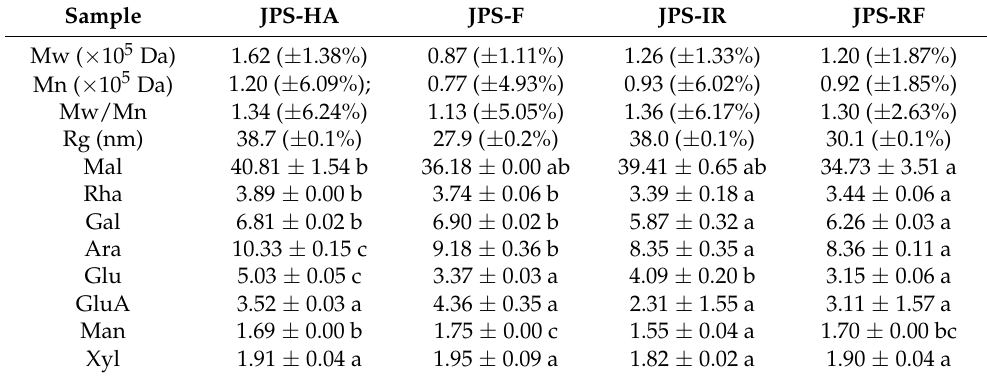
Table 2. Monosaccharide constituents and molecular weight of JPSs treated with different drying